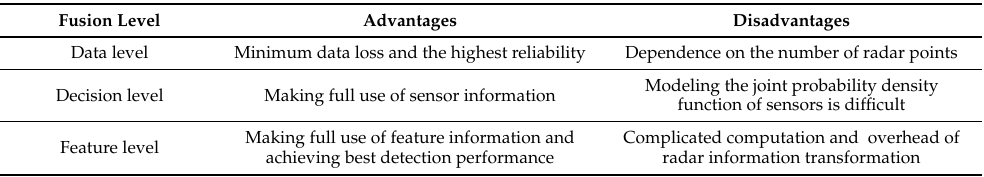
Table 4. Summary of the three fusion